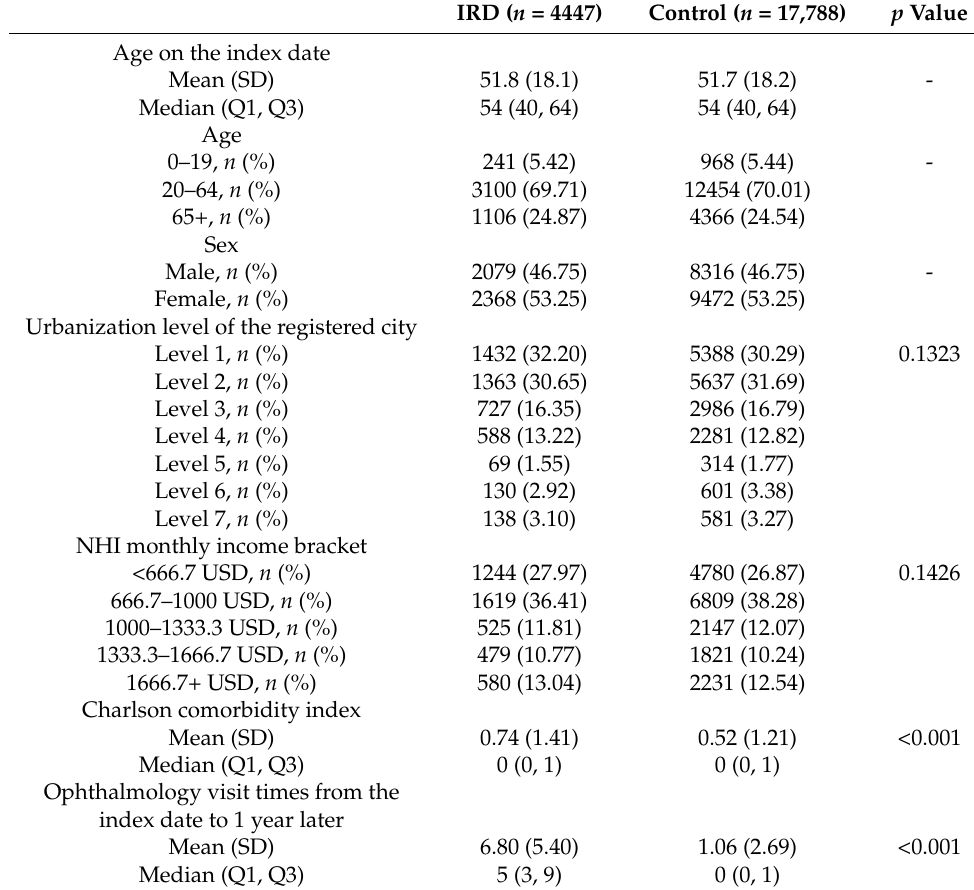
Table 1. Demographic Data of the Study